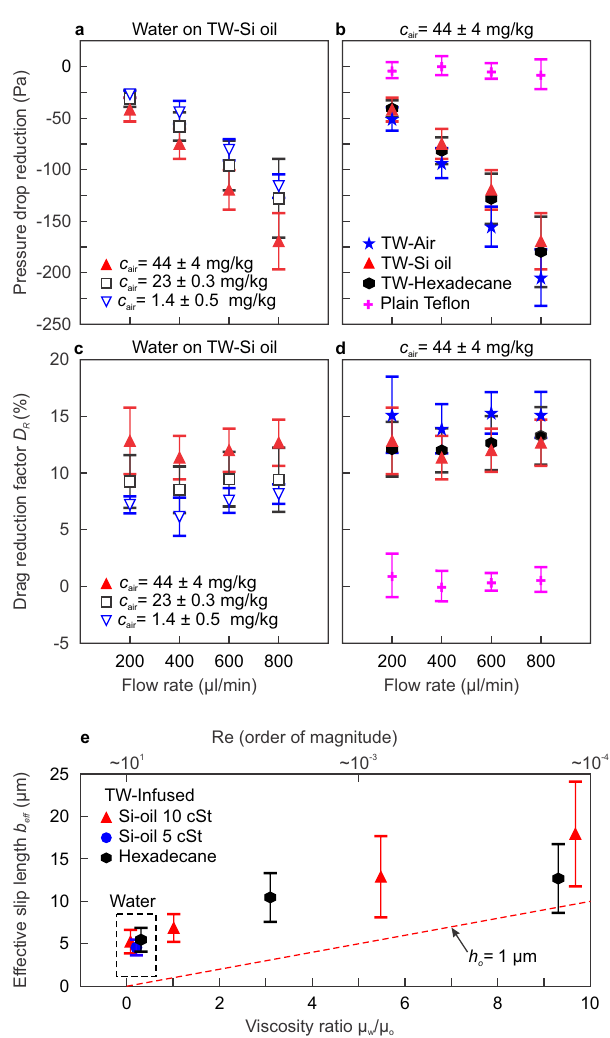
Fig. 3 Micro fl uidic measurements and estimation of the drag reduction and effective slip length. a Average pressure drop reduction measured for water over Te fl on-wrinkled surfaces infused with silicone oil 10 cSt (TW-Si oil) vs fl ow rate, for water with different air content c air . b Average pressure drop reduction vs fl ow rate, for water with air content c air ~44±4 mgkg − 1 for superhydrophobic Te fl on wrinkles (TW-air), TW infused with silicone oil 10 cSt and with hexadecane, and non-infused plain Te fl on sheets. c , d Drag reduction factor vs fl ow rate of water over the same surfaces reported in parts ( a ) and ( b ), respectively. The symbols in ( d ) are the same as in ( b ). e Effective slip length vs viscosity ratio at constant Ca = 0.001 for Te fl on wrinkles infused with silicone oil 10 cSt (red triangles) and 5 cSt (blue circle), and hexadecane (black hexagons). Water and glycerol – water mixtures with air content c air ~44±4 mgkg − 1 were used as working fl uid to achieve the shown viscosity ratio. The slip predicted from Eq. (1) is shown (red dashed line) for h o = 1 μ m. Each data point and error bar correspond to the average and standard deviation of at least 7 (and up to 22) repetitions using different micro fl uidic channels and different micro fl uidic devices (Supplementary Table S2). Source data are provided as a Source Data fi le. In all the experiments, the capillary number was fi xed at Ca = μ w U / γ w / o = 0.001 to keep the same balance of viscous to interfacial stress. As expected from the apparent slip model, a further increase in the effective slip length was observed by increasing the viscosity ratio. The maximum drag reduction measured was 28 ± 10%, obtained at viscosity ratio μ w / μ o = 9.7, corresponding to an effective slip length of b eff = 18 ± 6 μ m. Both NATURE COMMUNICATIONS| (2022) 13:351